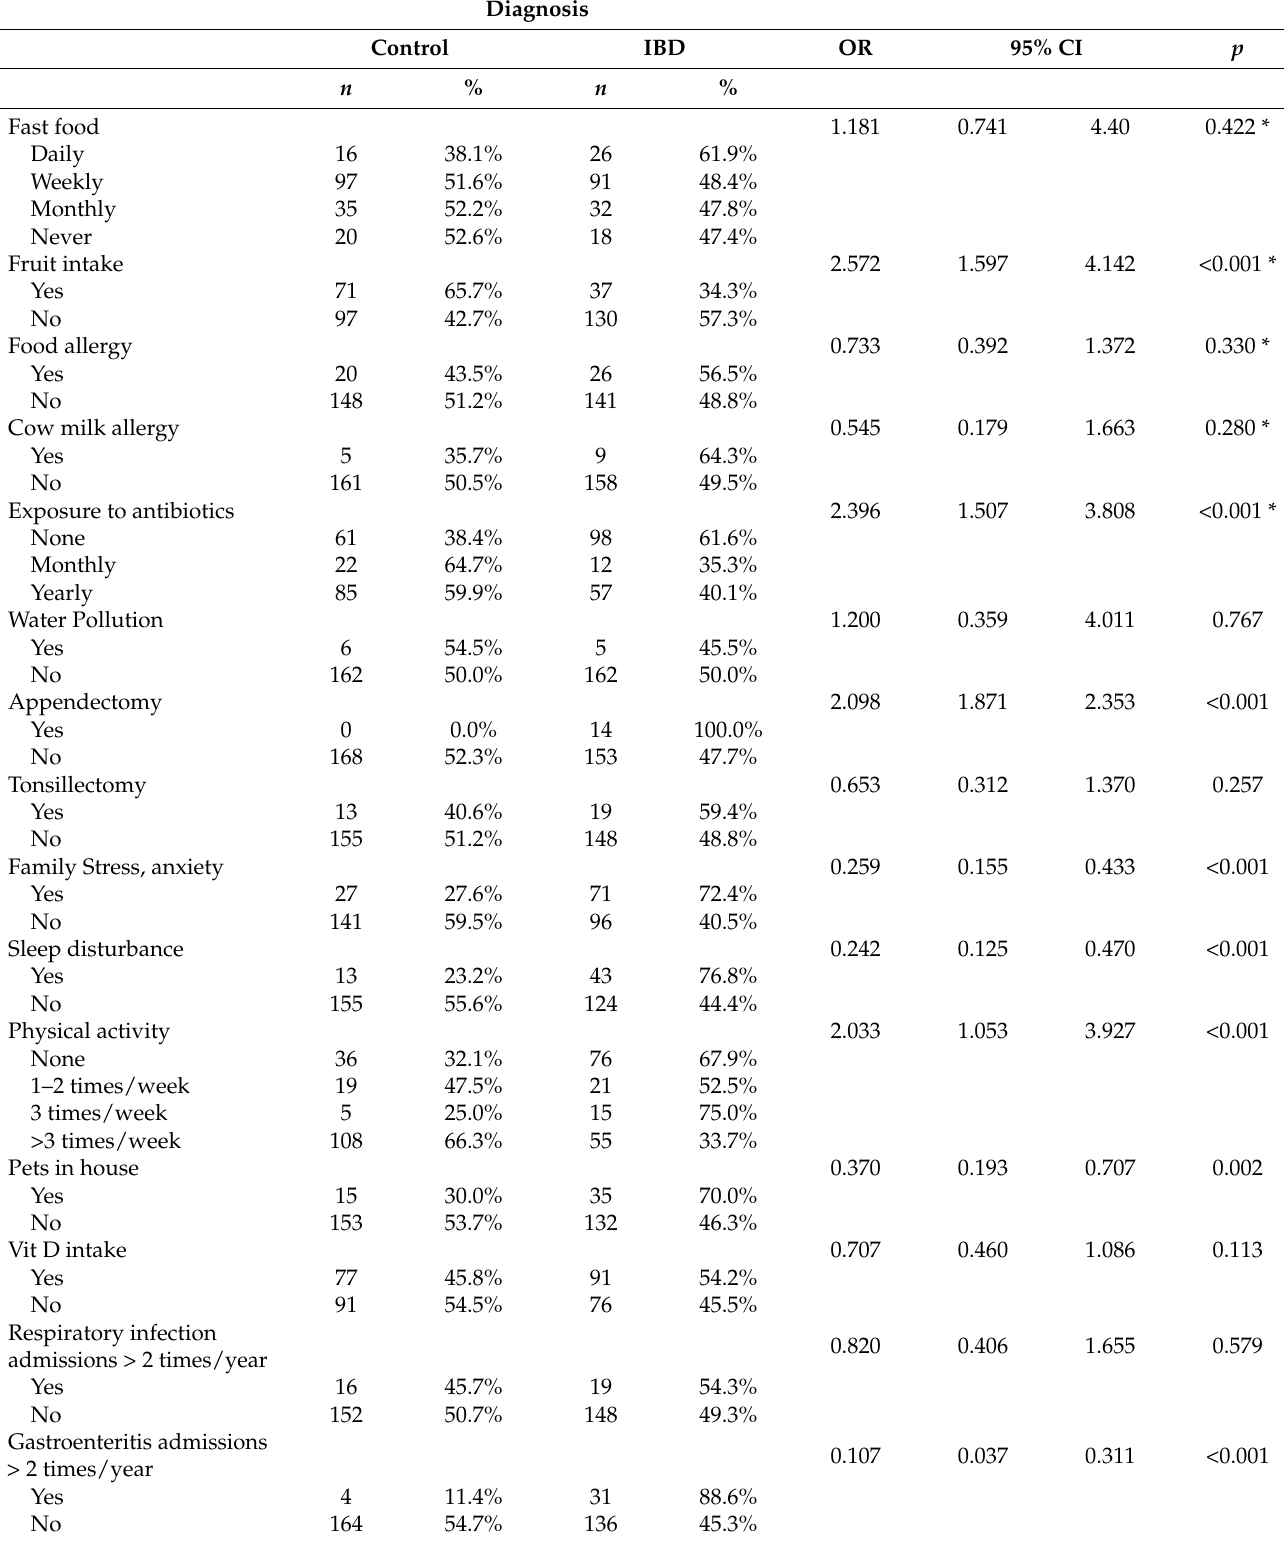
Table 3. Logistic regression analysis of risk factors and their association/non-association with IBD